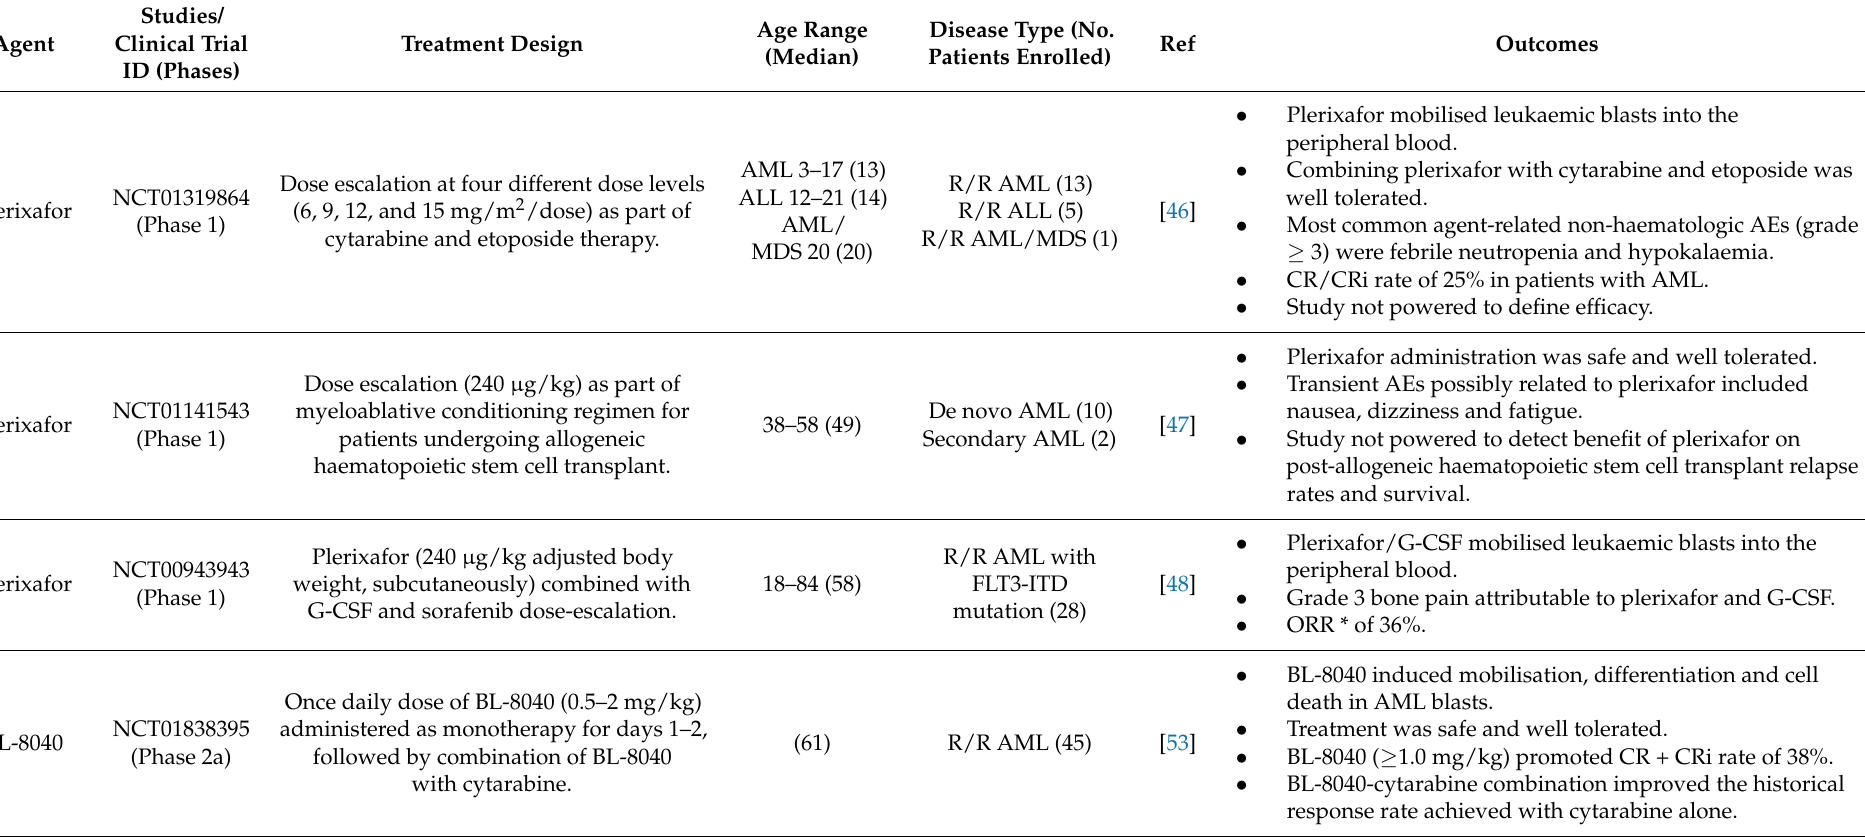
Table 2. Summary of clinical trial outcomes for therapeutic agents that target the leukaemic niche in the bone marrow